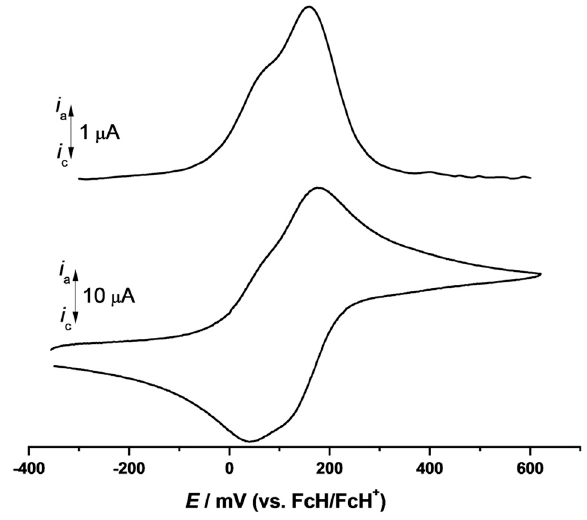
Figure 1. Cyclic voltammogram (bottom) and square-wave voltammogram (top) of 3 in anhydrous dichloromethane solutions (1.0 m M ) at 25 °C, supporting electrolyte [N n Bu 4 ] [B(C 6 F 5 ) 4 ] (0.1 M ), 100 mV/s.